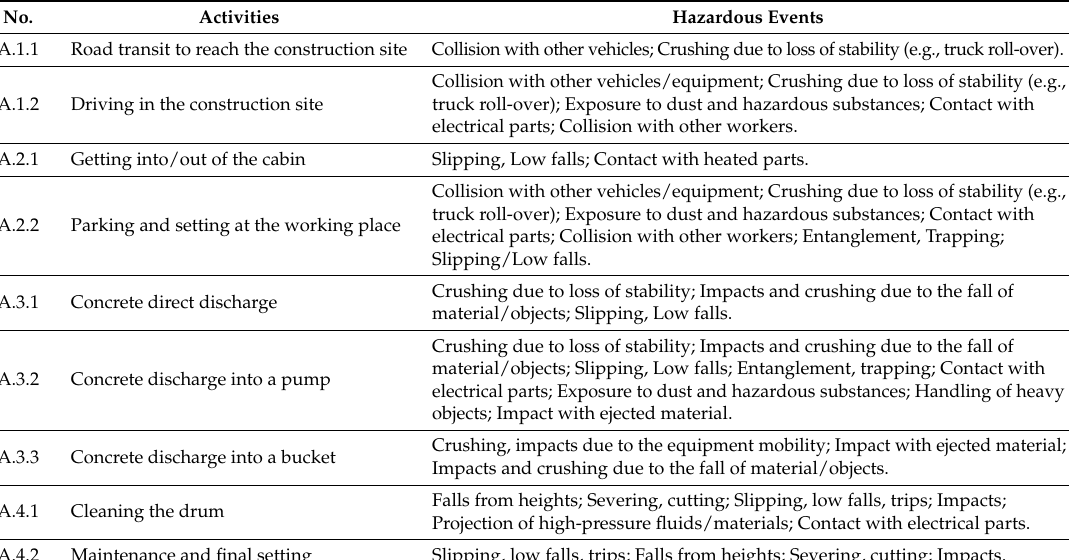
Table 1. List of hazardous situations/events related to each activity.